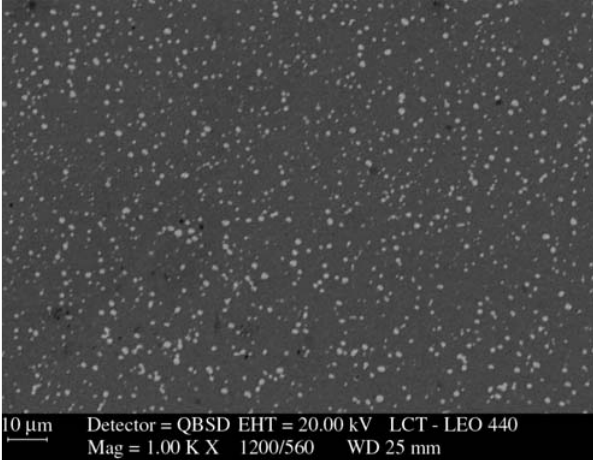
Figure 4. Scanning electron micrograph of Sinter 23 austenitized at 1200 °C and tempered at 560